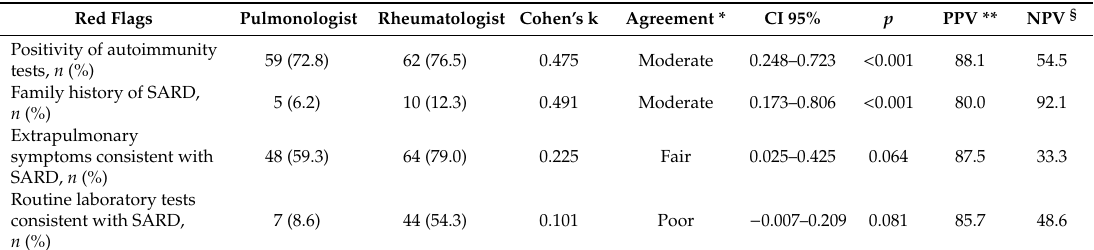
Table 2. Level of agreement between pulmonologist and rheumatologist in the identification of red flags for